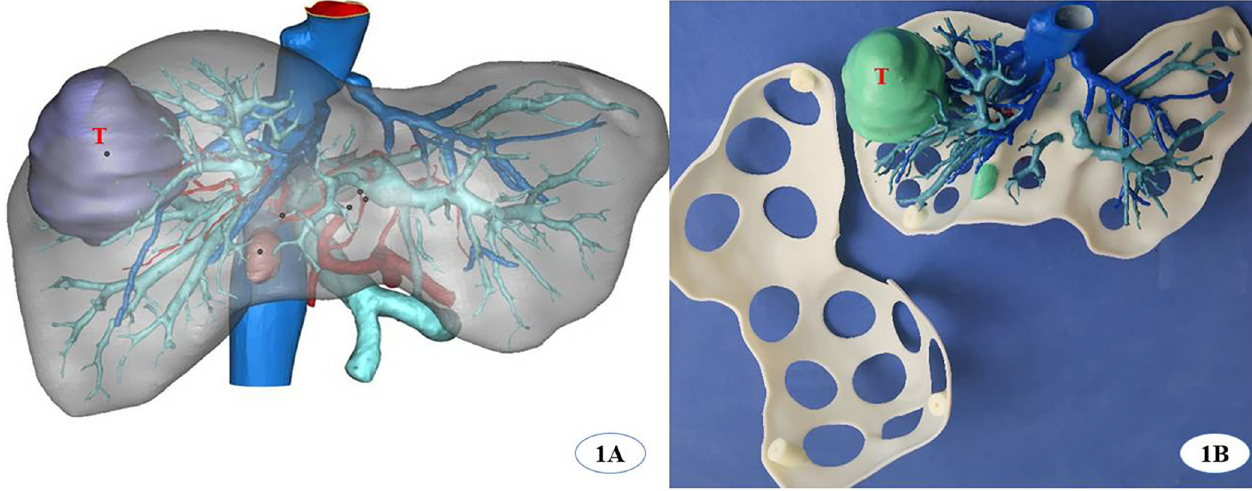
Fig 1. 3D virtual reconstruction based on CT data was shown on 1A, A 3D printing liver model modified by hollowed-out designation was shown on 1B. (T indicates tumor, dark blue vessels represent hepatic veins, light blue vessels represent portal veins, white plate full with holes represents liver surface).